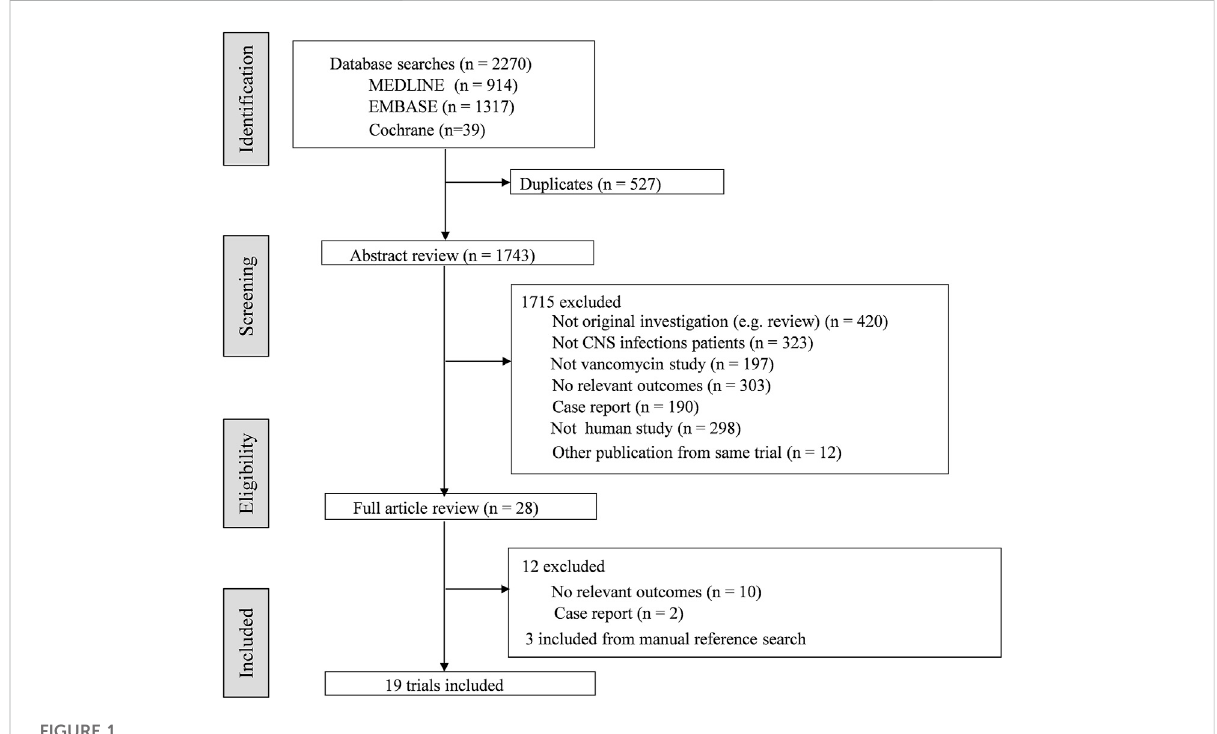
Flow chart of literature search and selection